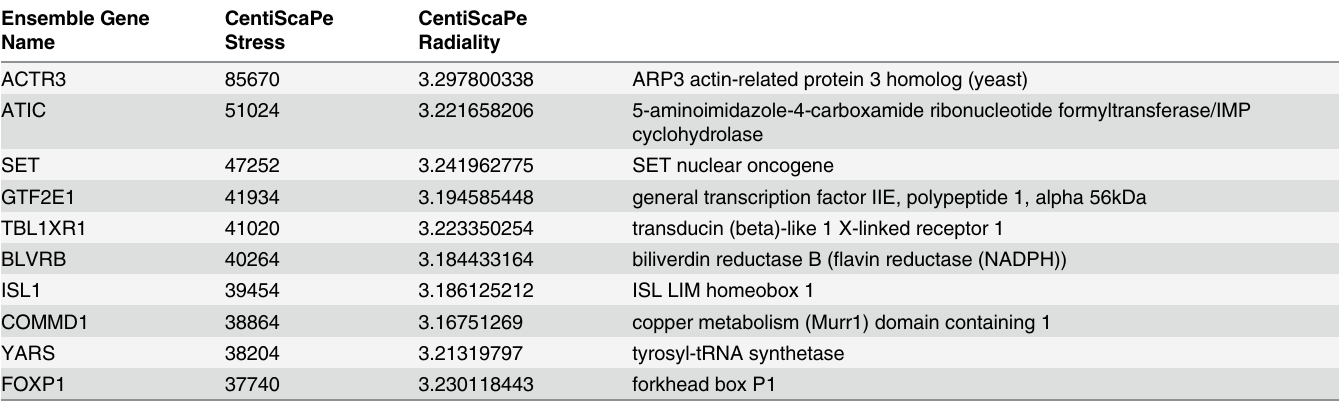
Table 2. Top ten most highly-related nodes in network of upregulated